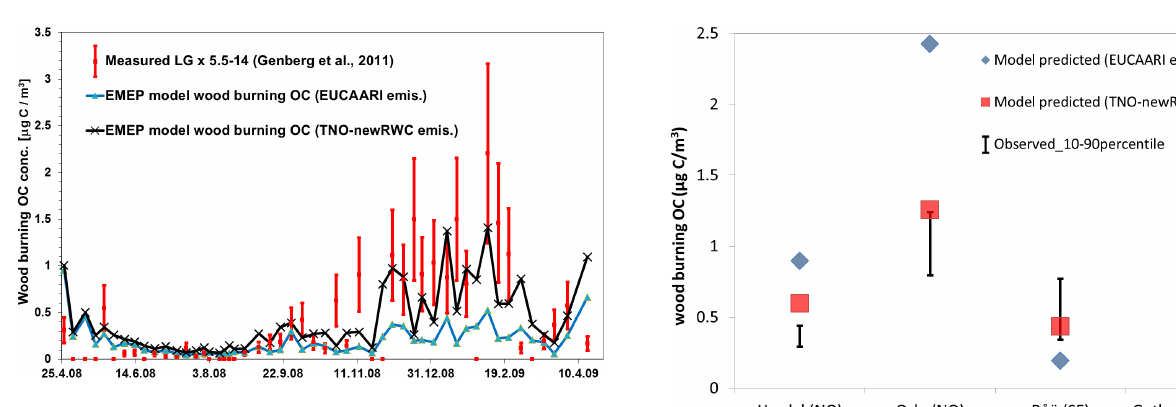
Figure 9. Comparison of EMEP MSC-W model-predicted OC (µg(C) m − 3 ) from biomass burning (bbOC) (including OC from both residential wood combustion and open vegetation fires) to bbOC estimated from levoglucosan concentrations at Vavi- hill (southern Sweden). Blue bars: model calculated bbOC with the EUCAARI emission inventory; black: model bbOC with the revised TNO-newRWC emission inventory. Red bars show the measurement-estimated bbOC range (lower limit: 5.5 × the mea- sured levoglucosan concentration, upper limit: 14 × levoglucosan; the estimated range for the bbOC/levoglucosan ratio, 5.5–14, is taken from Szidat et al., 2009).